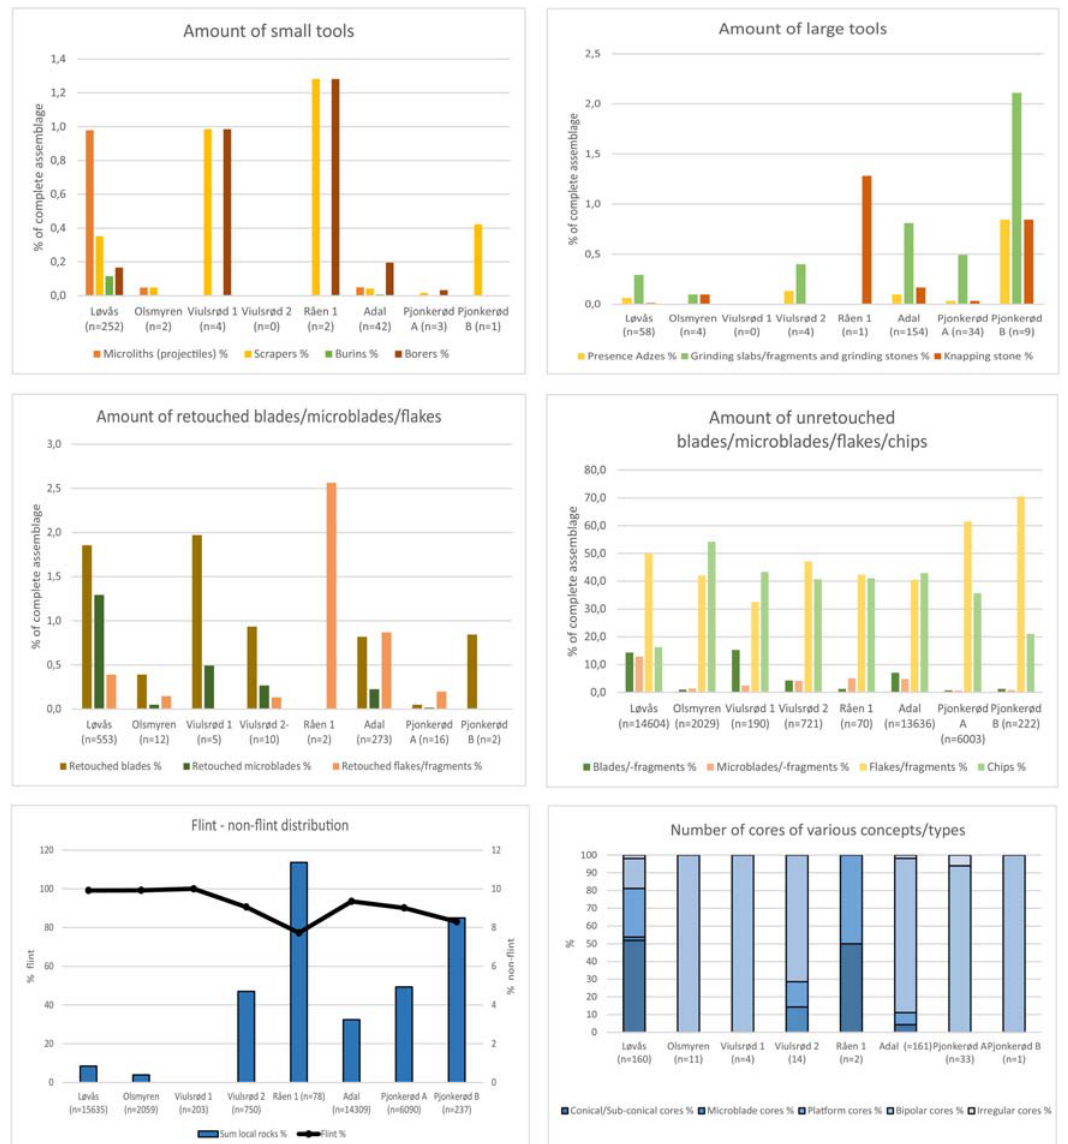
Figure 4: Diagrams illustrating the chronological development of the presence ( percent of total assemblage ) of tool types, core concepts, blades/microblades and di ff erent lithicrawmaterials between eight sites in Horten Municipality, northern Vestfold, – the oldest site Løvås to the left, the youngest Pjonkerød B to the right. The lower left diagram shows the relative distribution of fl int ( marked curve ) and non - fl int materials ( fi lled bars ) , between the assemblages. For data see Supplementary File